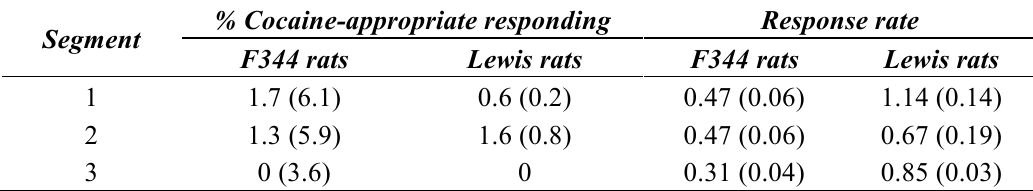
Table 2. Baseline Vehicle Test in Vehicle Test Groups . Mean (± S.E.M.) percent cocaine-appropriate responding and response rates (total lever presses/sec) during a cumulative dosing session with vehicle injections in F344 and Lewis rats in the vehicle test